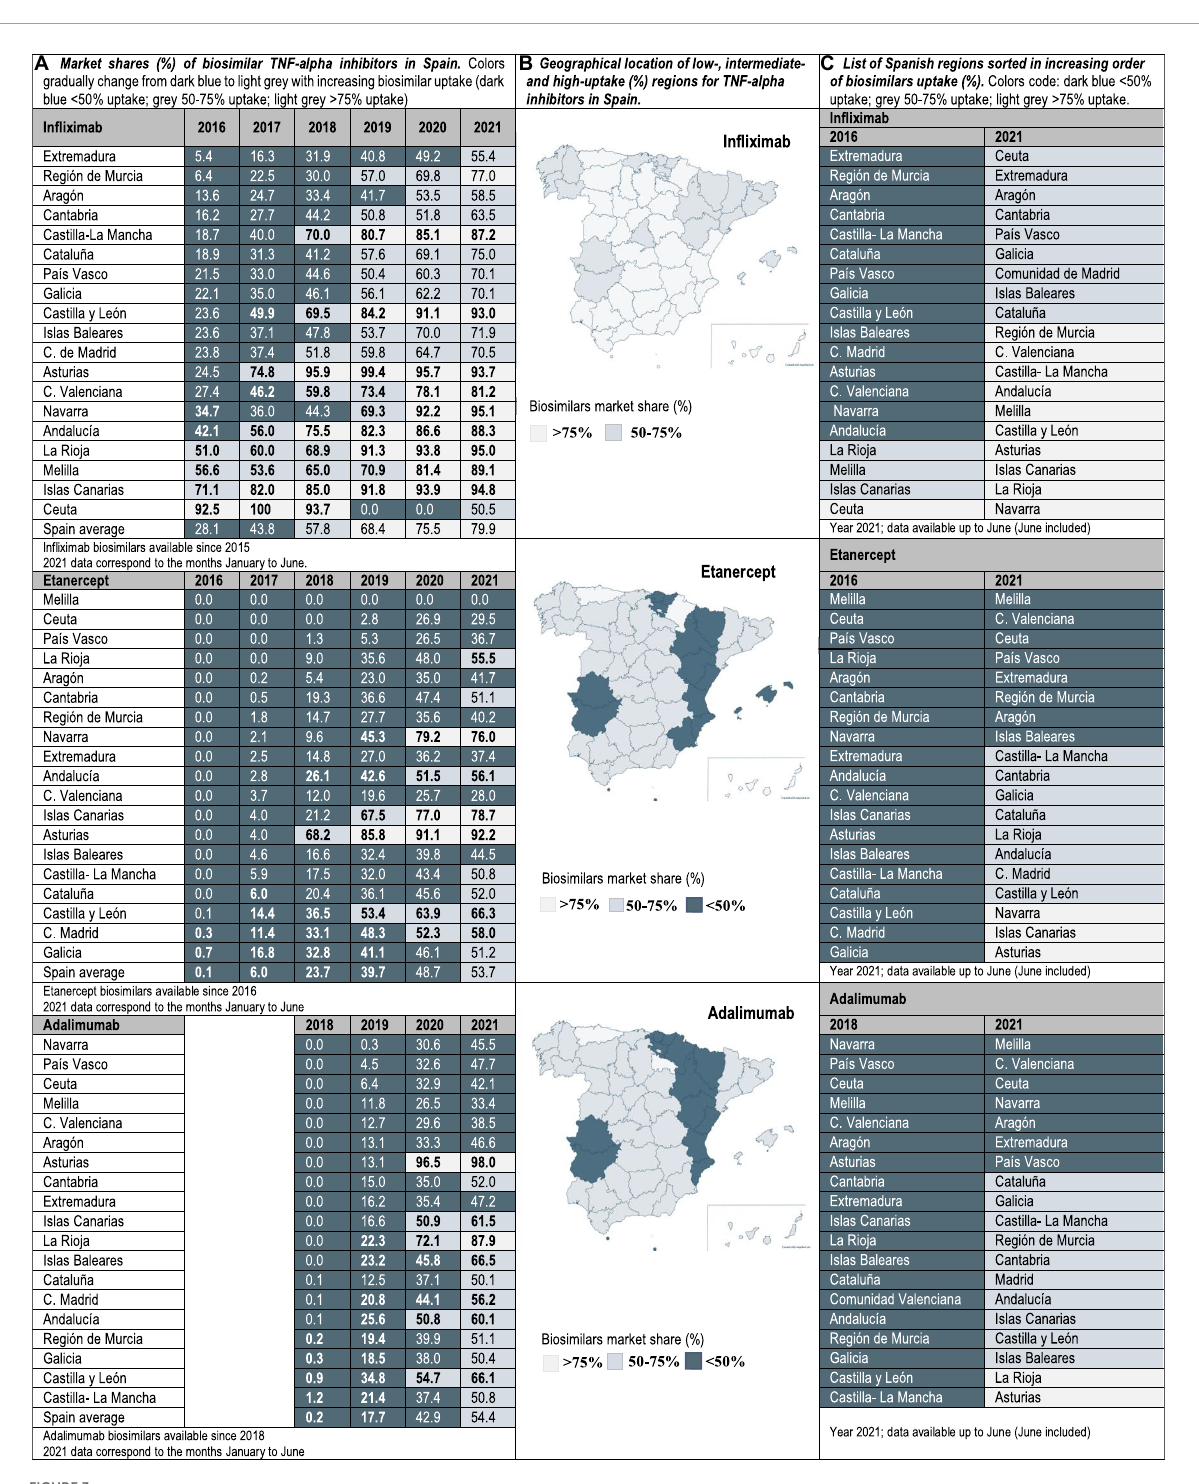
FIGURE3 (A) Market shares (%) of biosimilar TNF-alpha inhibitors in Spain. Data at the national/regional level are provided for infliximab (2016–2021), etanercept (2016–2021), and adalimumab biosimilars (2018–2021). (B) Geographical location of low-( < 50%), intermediate-(50–75%), and high-uptake ( > 75%) regions for TNF-alpha inhibitors in Spain. (C) List of Spanish regions sorted in increasing order of biosimilars uptake